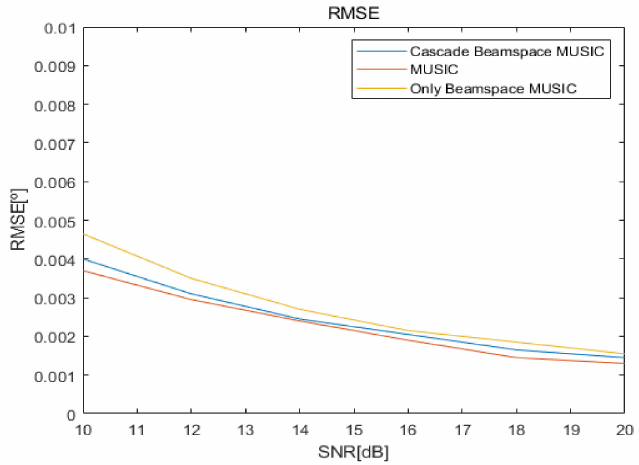
Figure 20. Root mean square error (RMSE) curves according to signal-to-noise ratio (SNR) of proposed cascade, MUSIC, and Beamspace